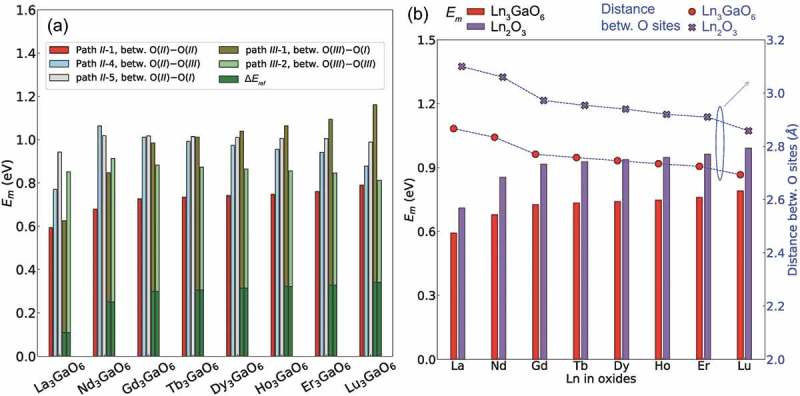
(a) Em for various migration paths of eight Ln3GaO6 (Ln = La, Nd, Gd, Tb, Ho, Dy, Er, or Lu) and (b) the lowest Em of the eight Ln3GaO6 and their counterpart Ln2O3 (left vertical axis) and the distances between O sites for the migration path in the crystal structure (right vertical axis).